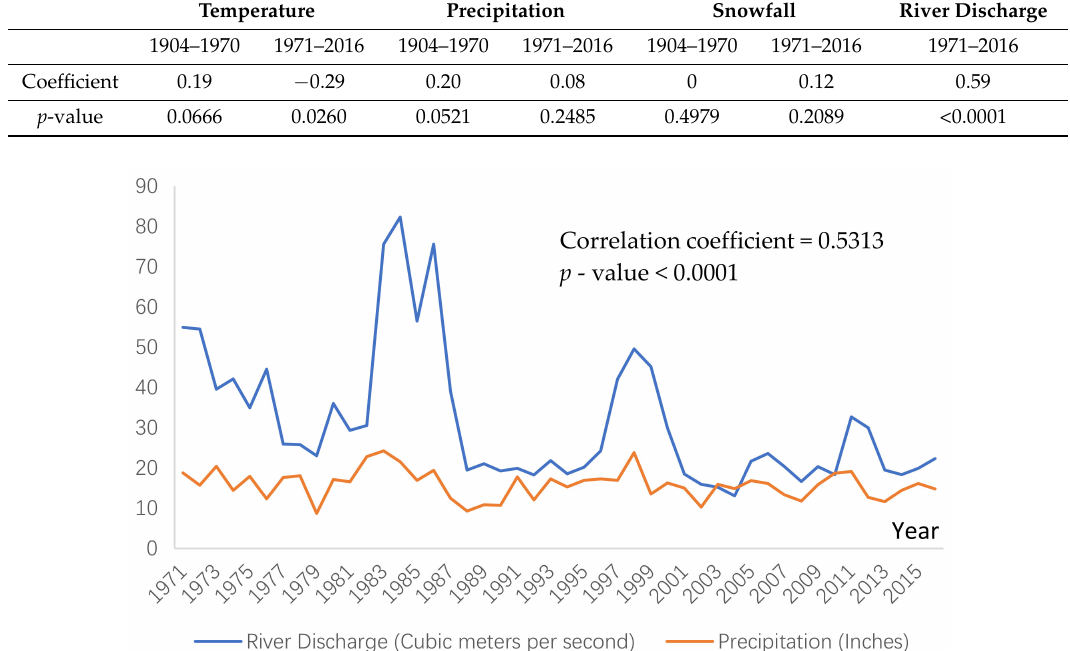
Figure 6. River discharge is highly and significantly related to